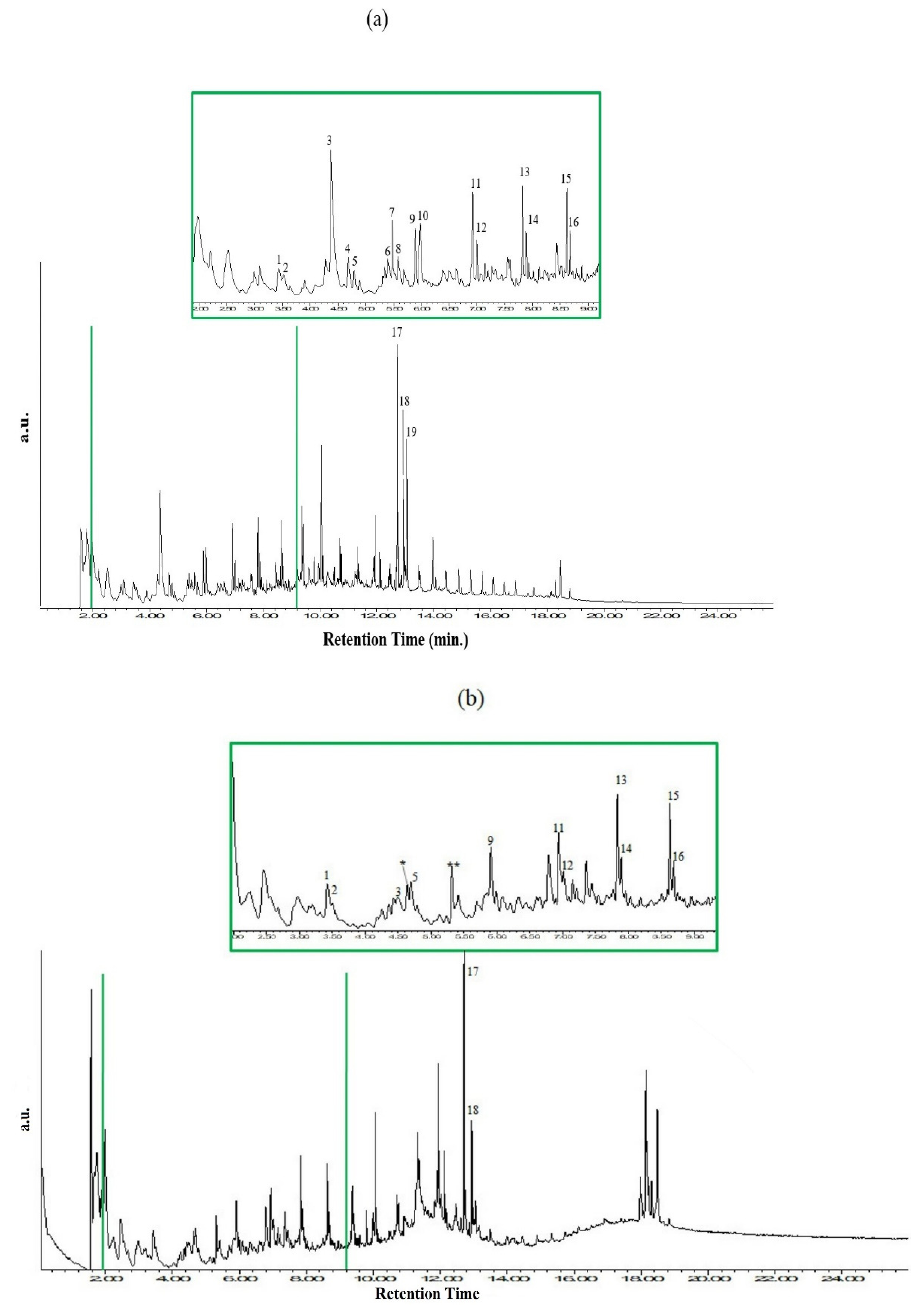
Figure 3. Complete pyrogram and pyrogram fragment between retention times 2.0 and 9.5 min (defined with two vertical green lines in the complete pyrogram) after pyrolysis at 600 ◦ C. ( a ) Dry Desmodesmus sp. with alumina catalyst; ( b ) n-hexane extract of Desmodesmus sp. with alumina catalyst. Identification of some products in the complete and limited fragment pyrograms: (1) 1-Heptene; (2) n-Heptane; (3) Toluene; (4) 1-Octene; (5) n-Octane; (6) 1H-Pyrrole, 3-methyl-; (7) 1H-Pyrrole, 2-methyl-; (8) Ethylbenzene; (9) 1-Nonene; (10) Styrene; (11) 1-Decene; (12) n-Decane; (13) 1-Undecene; (14) n-Undecane; (15) 1-Dodecene; (16) n-Dodecane; (17) 3-Octadecyne; (18) Hexadecanal; (19) Pentadecanenitrile; (*) 1-Heptene, 2-methyl-; (**) 2,4-Dimethyl-1-hexene.